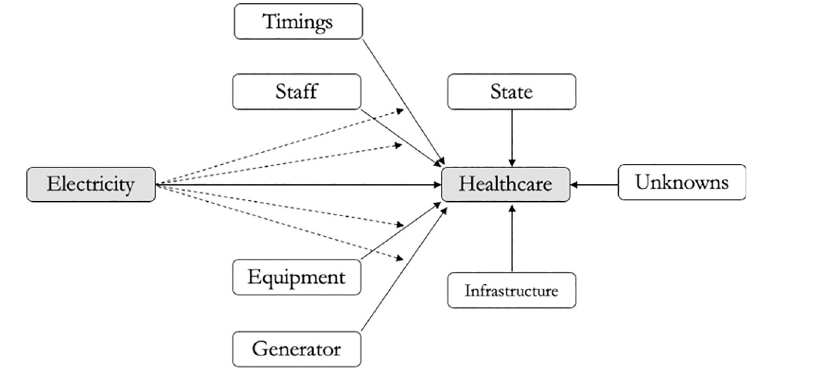
Fig 2. Direct and indirect effects of electricity access on healthcare